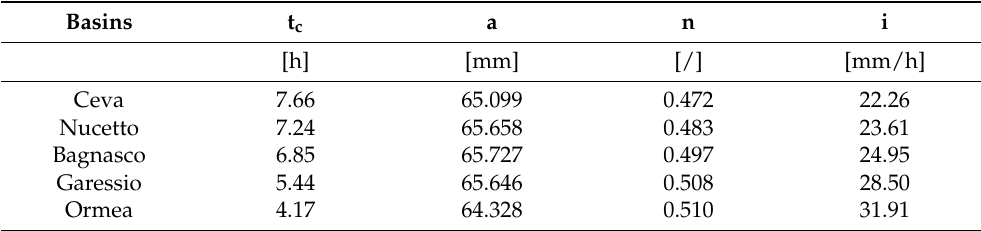
Table 3. Evaluation of the maximum expected rainfall intensity (i) according to Equation (2) for a recurrence period of 200 years, calculated for the five sub-basin of the UTV.